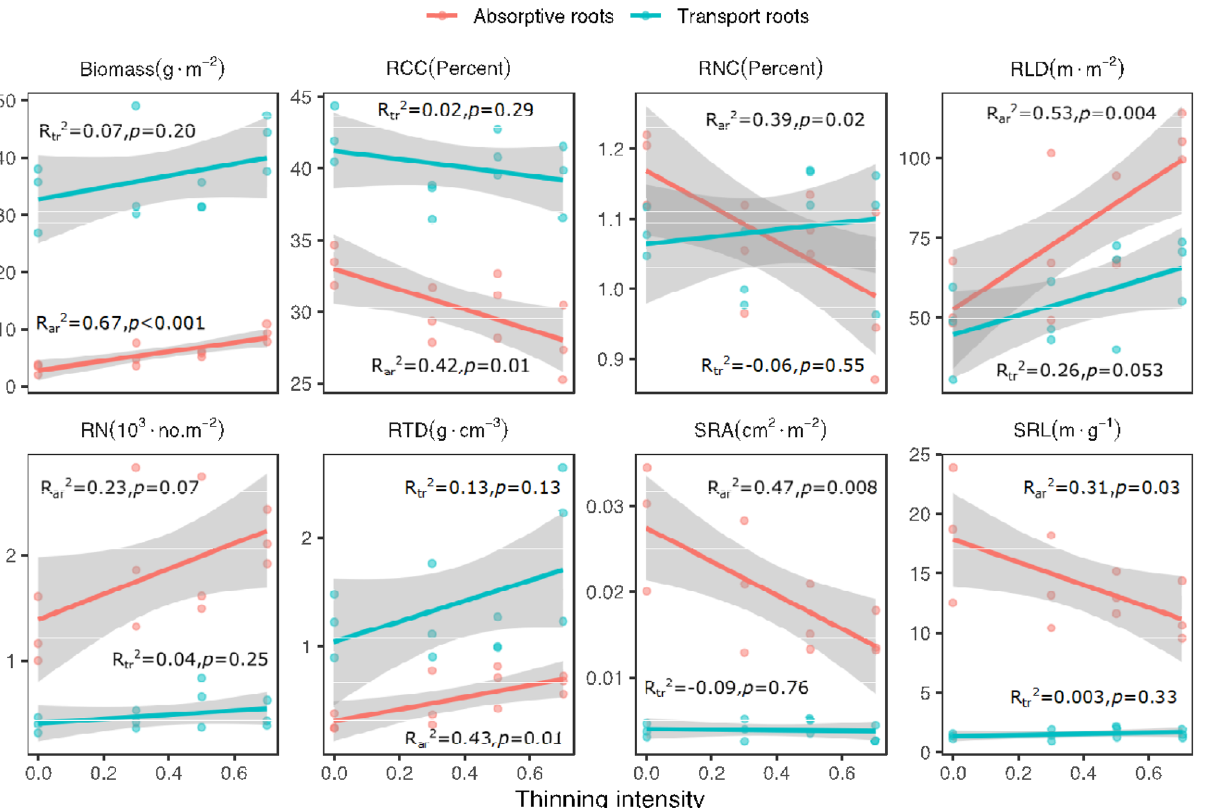
Figure 2. Variation in functional traits of the absorptive roots (red lines and dots) and the transport roots (blue lines and dots) along the thinning intensity. Adjusted R-squared and p-value of the linear regression models (according to the linear regression analysis) for the absorptive roots (R ar 2 ) and transport roots (R tr 2 ) are showed. Regression lines with 95% confidence intervals (grey shades) show the prediction of linear models.